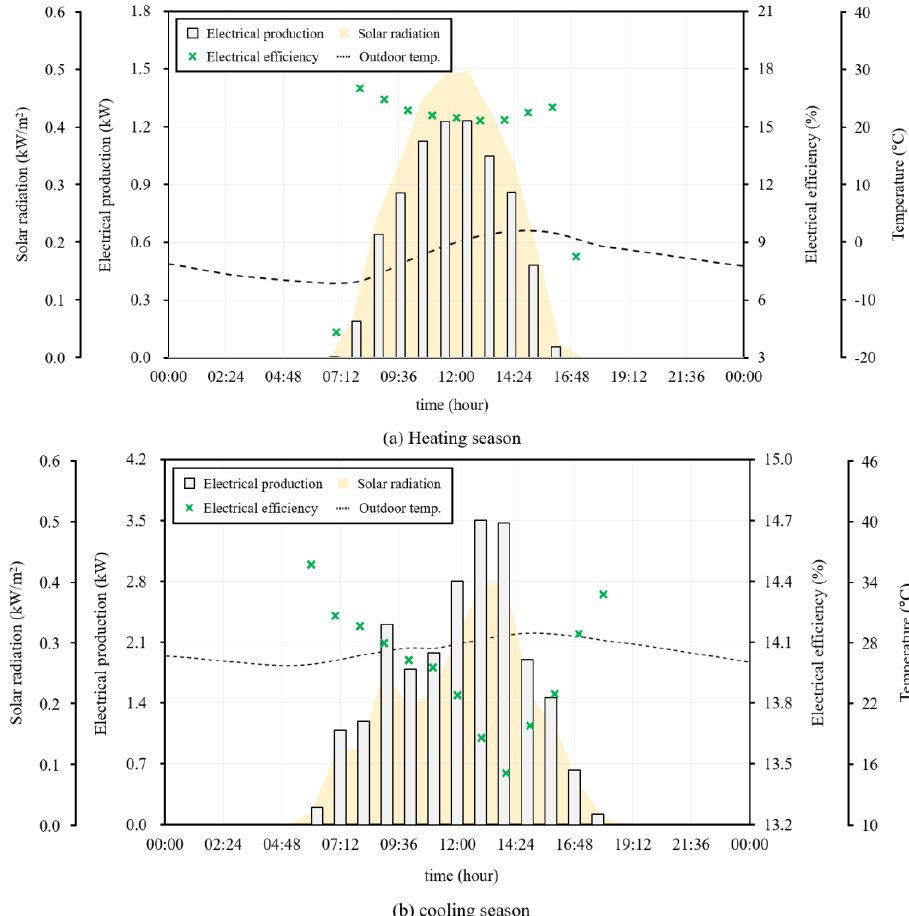
Figure 8. Electrical performance of the PVT module; ( a ) heating season, ( b ) cooling